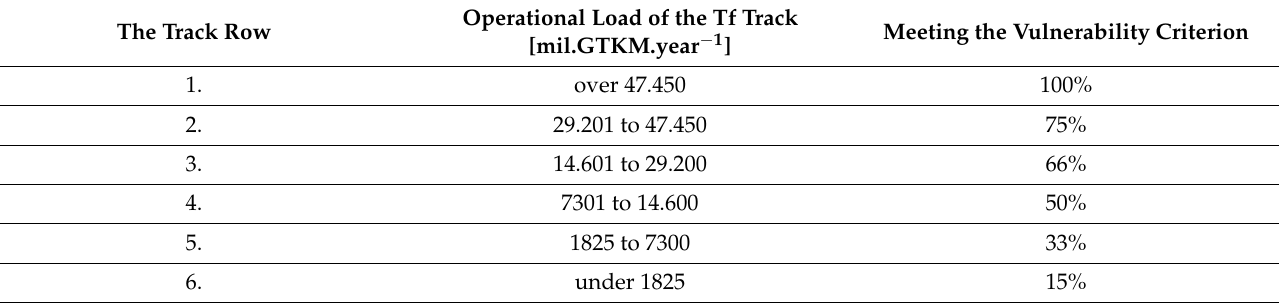
Table 11. Operational Load of the Track.